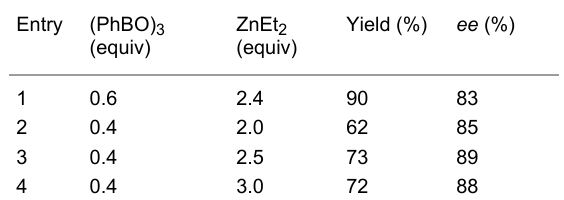
Table 1: Optimization of batch conditions for the phenylation of tolual- dehyde with triphenylboroxin with 2 as the catalyst.